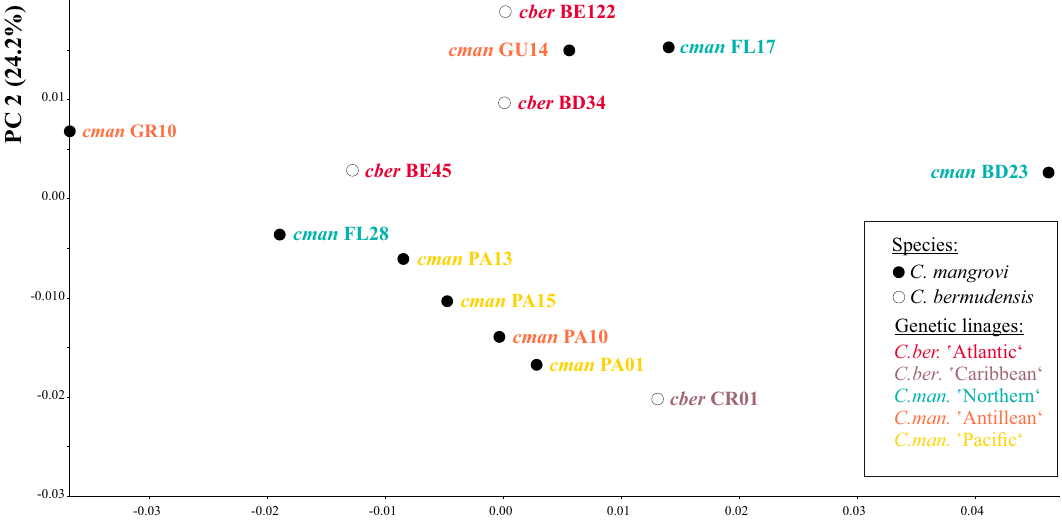
Figure 4. Claw shape in different species and genetic lineages within the genus Carinozetes . PCA scatterplot of population mean shapes of 13 Carinozetes populations. Colors refer to genetic lineages as shown in legend and codes refer to populations as given in Table